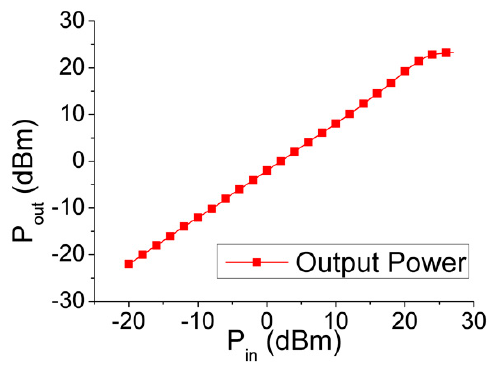
Figure 13. Measured output power versus input power of the SPDT switch at 38 GH z .